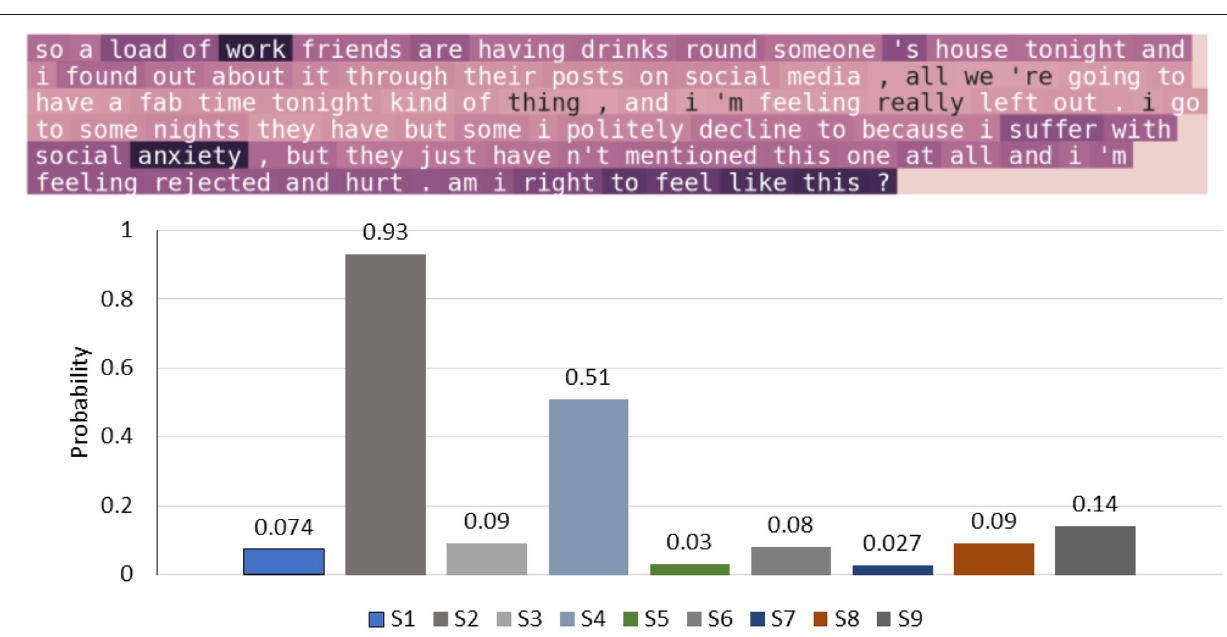
words are highlighted, which represent work, anxiety, feel, and suffer ; they indicate two symptoms, i.e., S1 (felling down depressed or hopeless) and S4 (feeling tired or having little